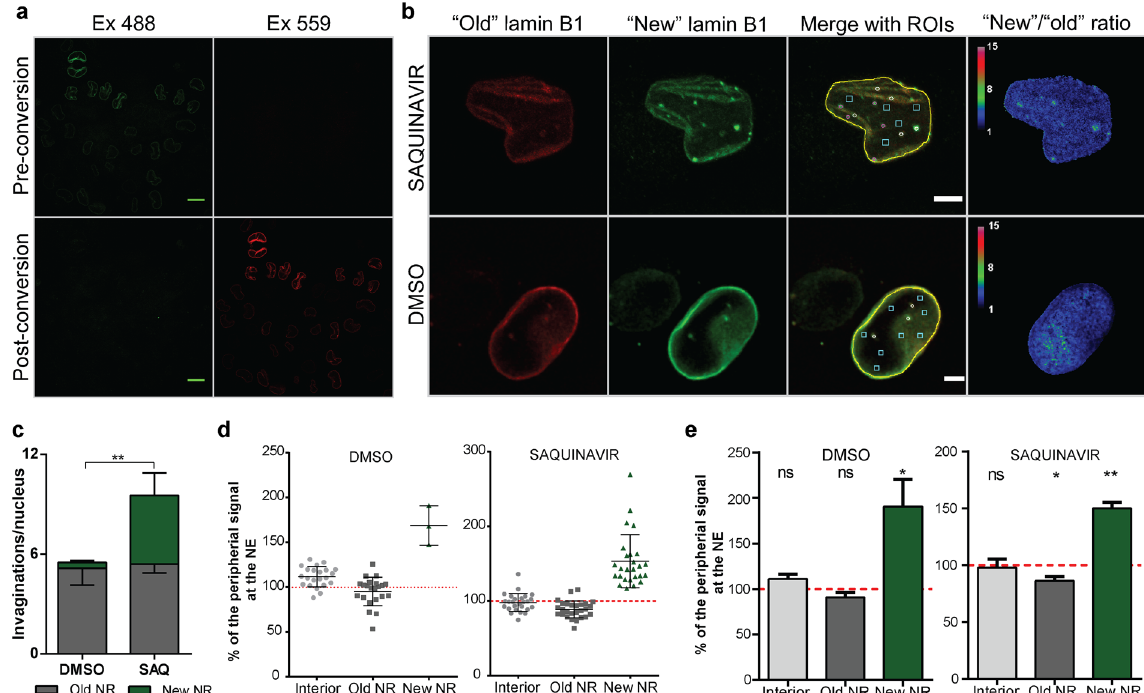
Figure 3. MAPLE3 photoconvertible tag allows tracking of nascent lamin B1 delivery to newly forming NR. ( a ) Confocal microscopy on HeLa cells 24 hours post-transfection with MAPLE3-lamin B1 encoding plasmid. Top panel corresponds to cells imaged before photoconversion (Pre-conversion) that emit green fluorescence upon excitation with 488 nm laser (Ex 488), but no red fluorescence upon excitation with 559 nm laser (Ex 559). Bottom panel (Post-conversion) presents the same cells imaged immediately after photo-conversion with 405 nm light, revealing complete switch in fluorescence emission from green (Ex 488) to red channel (Ex 559). Scale bar, 10 µ m. ( b ) HeLa cells treated with either saquinavir or vehicle control (DMSO) and imaged 22–26 hours after complete photoconversion of MAPLE3-lamin B1. “Old” lamin B1 channel corresponds to the pool of lamin B1 existing in the cell immediately after photoconversion, while “new” lamin B1 corresponds to nascent copies of lamin B1 delivered to the nucleus post-conversion. Merge image shows Regions of Interest (ROIs) as follows: yellow line, nuclear periphery; white circles, old NR (structures visible in red channel); magenta circles, new NR (structures visible in green channel only); cyan squares, nuclear interior without structures. Ratiometric image comparing pixel intensities of green channel (“new” lamin B1) over red channel (“old” lamin B1). Scale bar, 5 µ m. ( c ) NR invagination count in control (DMSO) and saquinavir-induced (SAQ) cells. Old NR has been identified in red channel, while new NR was defined by structures present in green channel only. Results from three independent experiments, 54 cells in total per condition; mean ± SD. ( d ) An example data plot from a single experiment showing distribution of “new”/”old” lamin B1 ratio at different nuclear structures and normalised to the nuclear rim ratio. ( e ) Pixel intensities of the ROIs defined in (B) based on the ratiometric images and normalised to the signal at the nuclear rim showing increased incorporation of nascent lamin B1 at the newly forming NR channels; results from three independent experiments, 54 cells in total; mean ± SD; ** p < 0.001; * p < 0.05; ns, p not